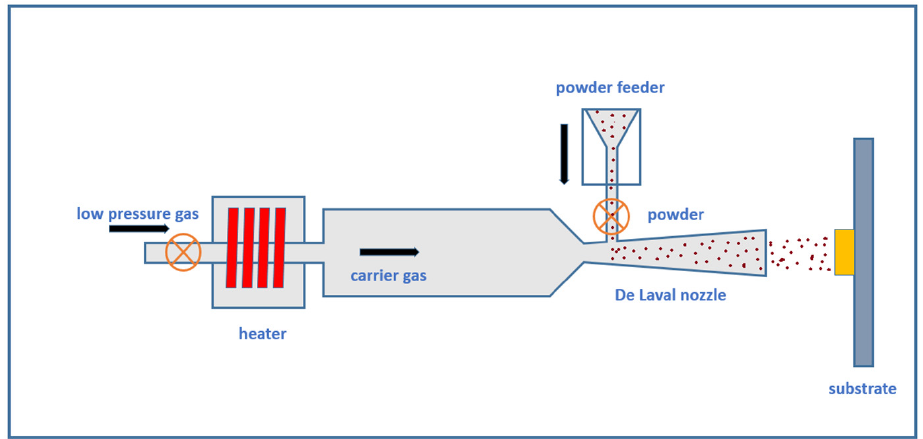
Figure 4. The low-pressure cold spray process.